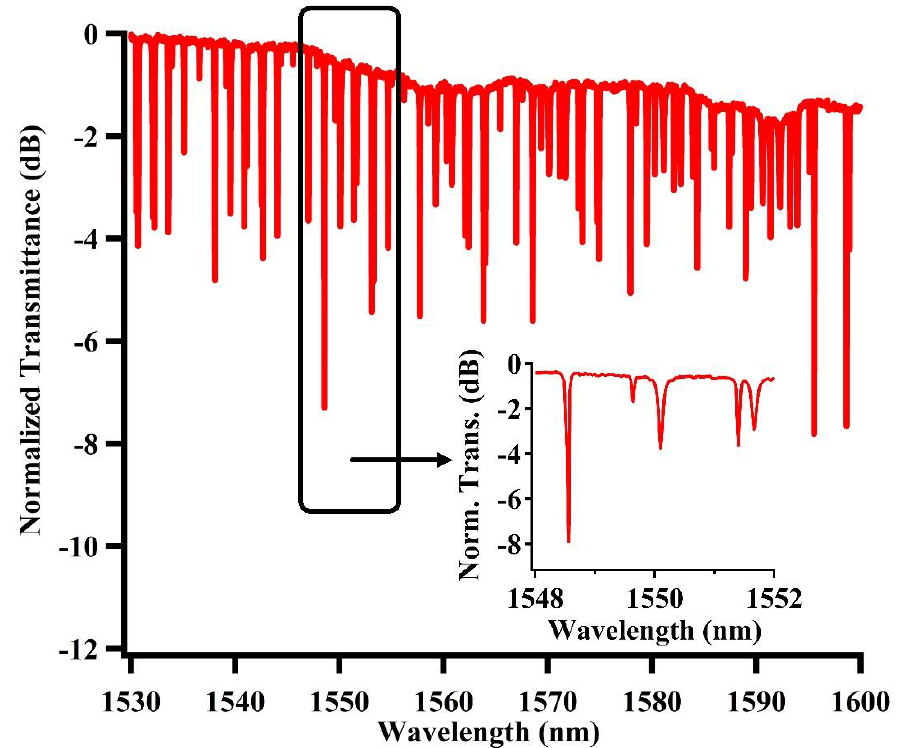
Figure 5. Measured normalized transmission spectrum of the gourd-shaped ring resonator system. Inset: enlarged spectrum around 1550 nm wavelength.